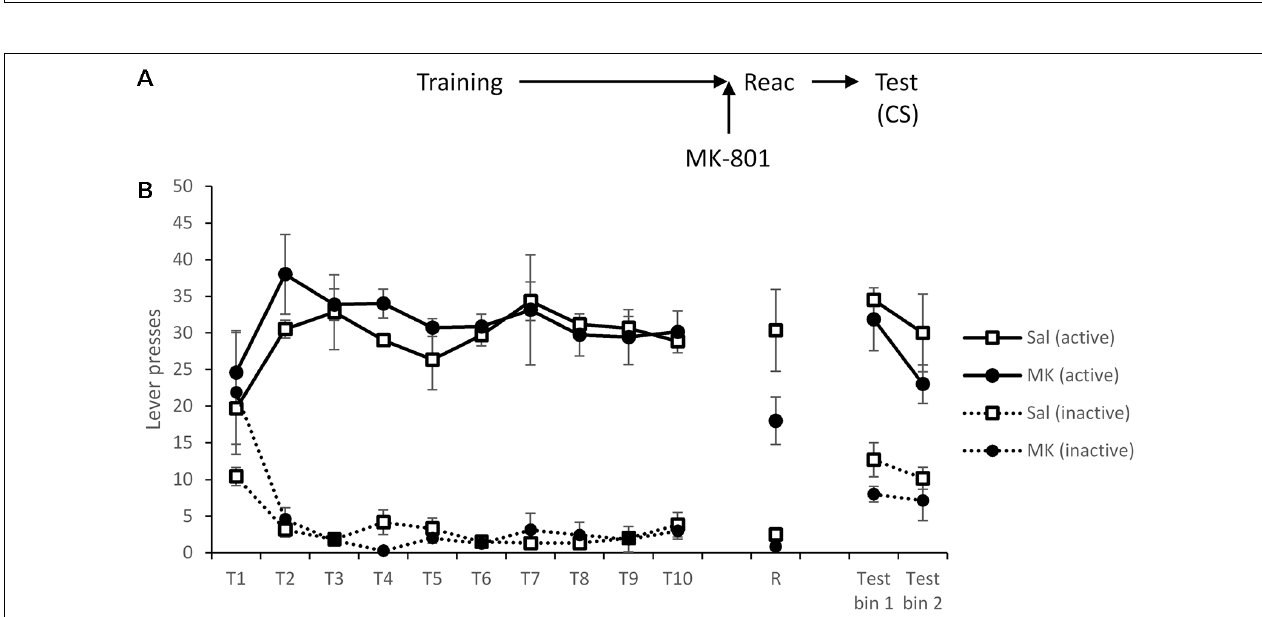
FIGURE 2 | Presentation of a cocaine-paired conditioned stimulus (CS) maintained lever pressing at test, regardless of prior disruption of reconsolidation with MK-801. (A) Schematic of the experiment. (B) Rats acquired cocaine-seeking successfully over training days 1–10 (T1–T10). At reactivation (R), lever pressing was slightly reduced by MK-801 ( n = 7) compared to saline controls ( n = 6), although this was not statistically significant. During testing, active lever responses triggered a 1 s presentation of the cue light. This was sufficient to recover responding of MK-801 treated rats to control levels. Data are presented as summary mean ± SEM.